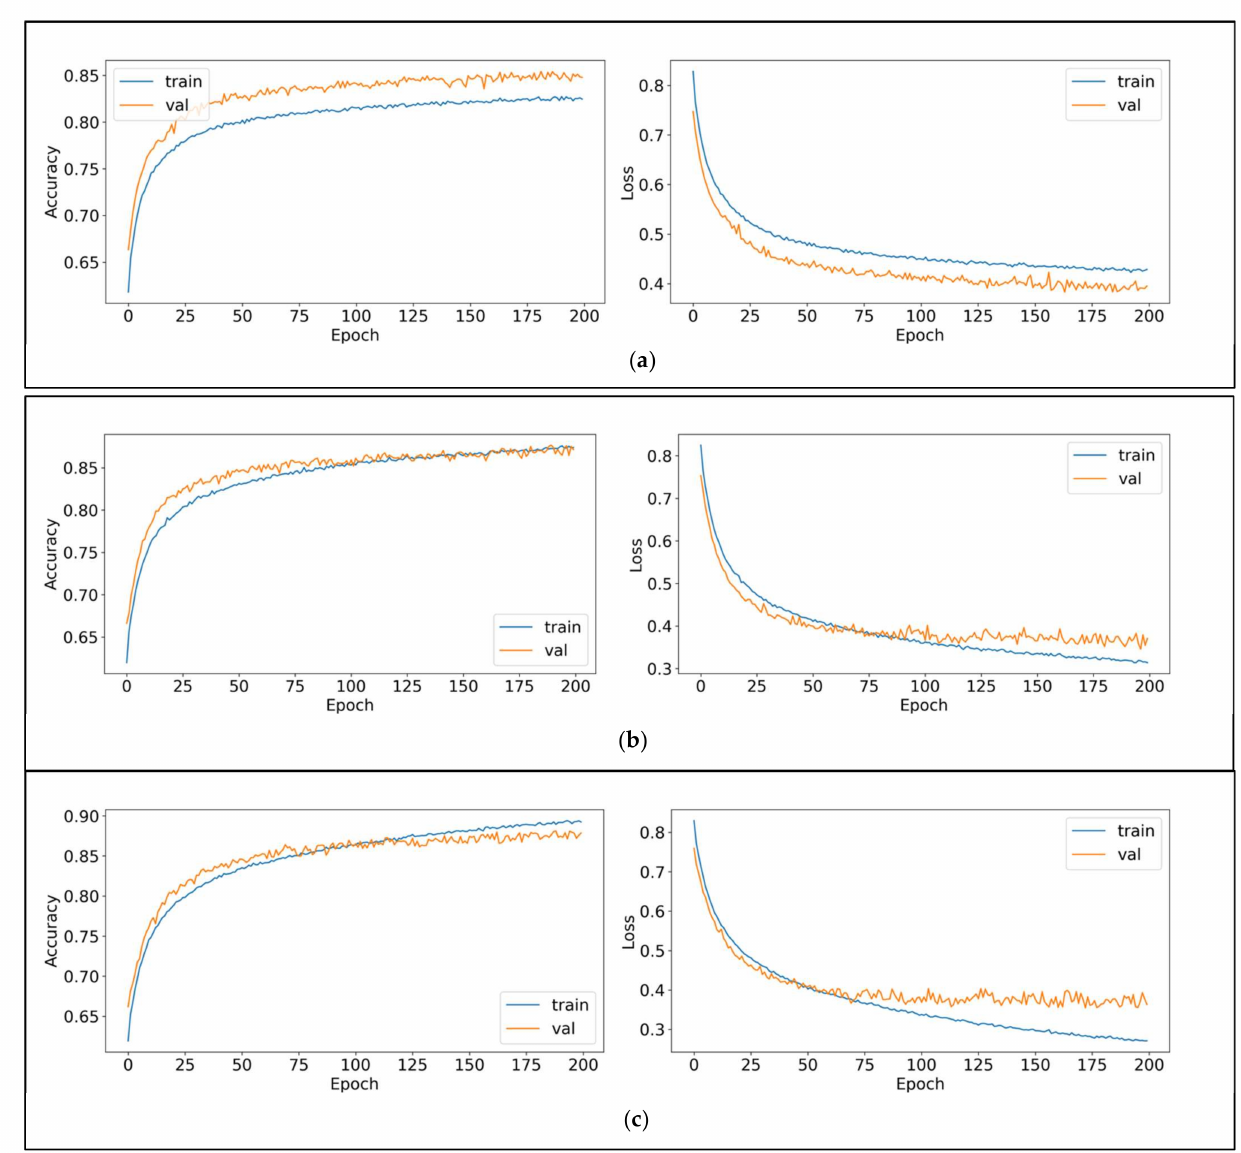
Figure 8. Training accuracy and training loss of the LSTM using GloVe embedding: ( a ) single-layer architecture; ( b ) double-layer architecture; ( c ) triple-layer